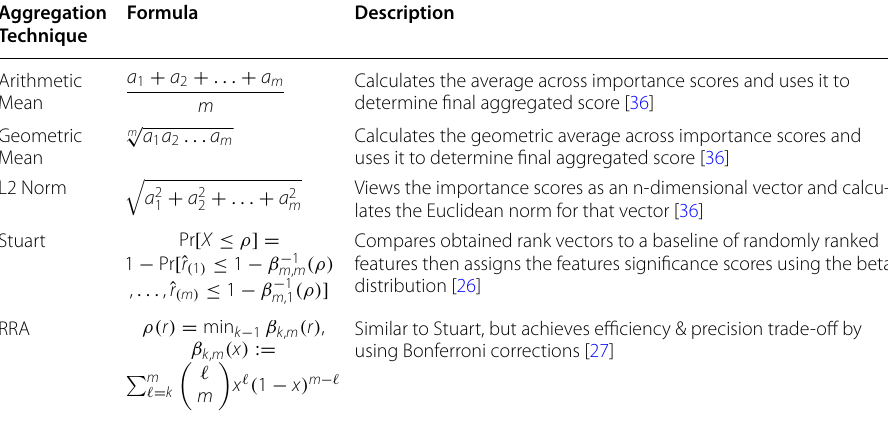
Table 2 Details of aggregation techniques Aggregation Technique